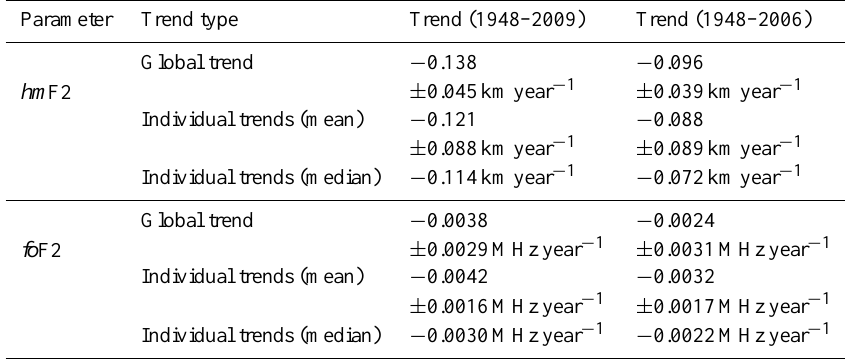
Table 2. Estimated mean trend values of hm F2 and fo F2 with error bars using F10.7 data as solar activity index in the trend analyses of 113 stations with hm F2 values and 124 stations with fo F2 data for two different time intervals (1948–2009 and